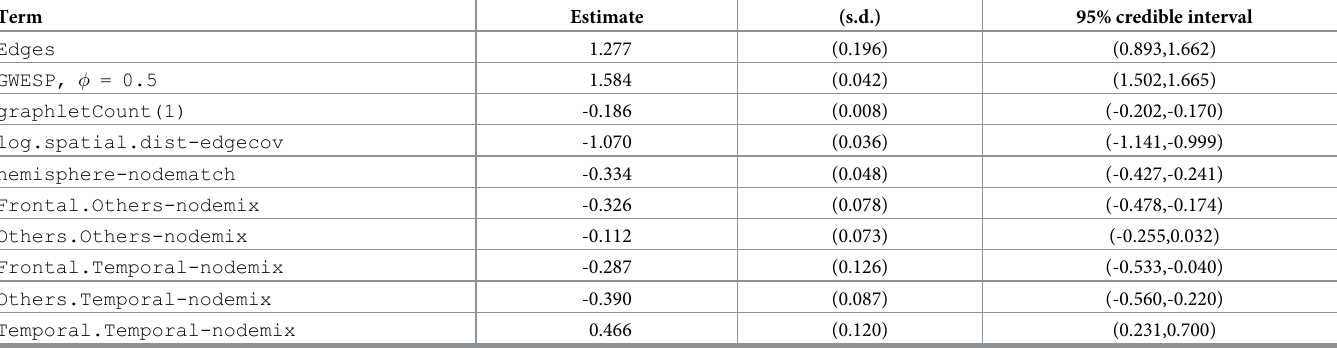
Table 6. MAP estimates and posterior standard deviations, conjugate Bayesian analysis of brain functional connectivity networks. (For nodemix effects, Fron- tal-Frontal is the reference